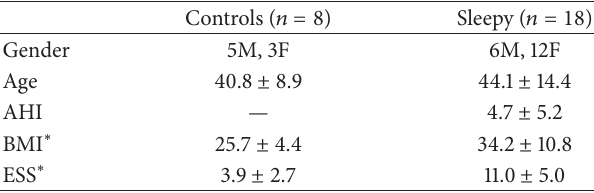
Table 3: Demographics for “sleepy” subjects and